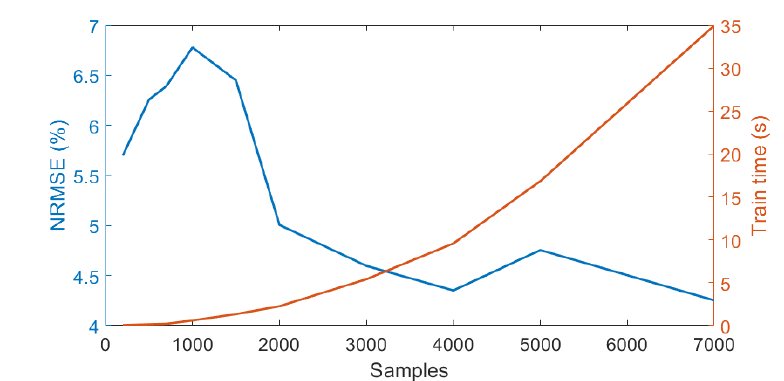
Figure 6. NRMSE (in %) (blue axis) and associated processing time (orange axis) of the KRR emulators (20 PCA input, 5 PCA output) built with a varying number of training